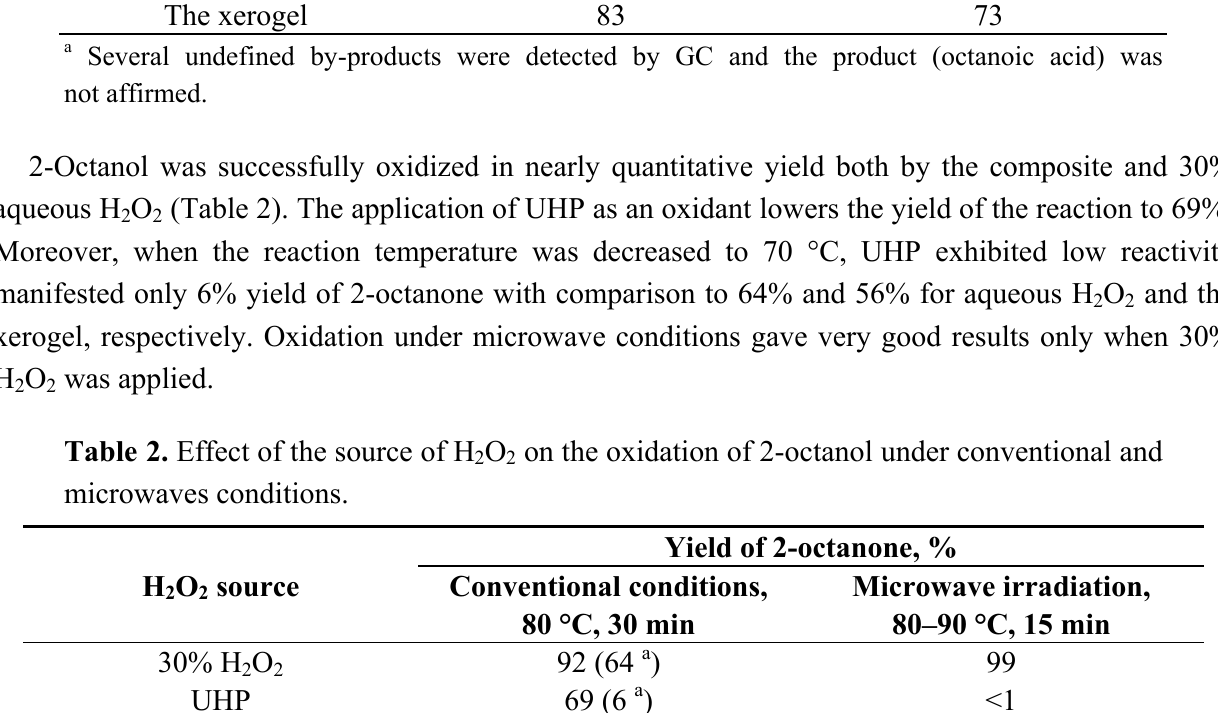
O on the oxidation of octanal under conventional and 2 2